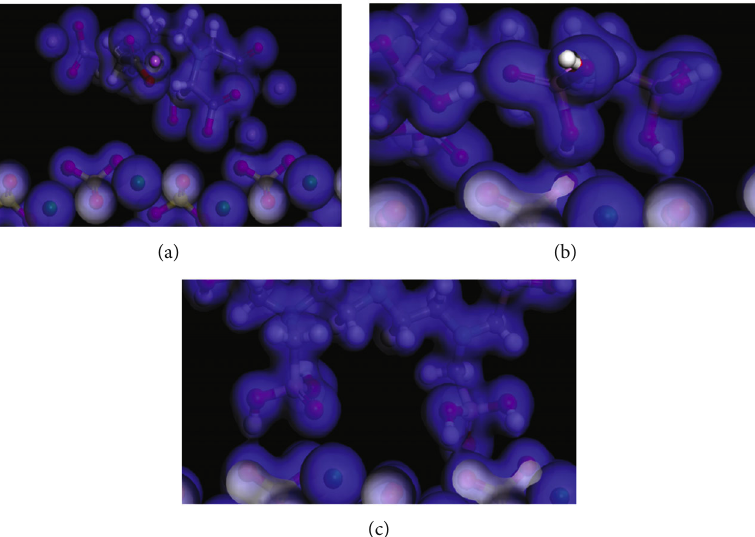
Figure 8: Di ff erence charge density of (a) DTPA-5Na, (b) EDTMPS, and (c) DTPMP are absorbing on (001) surface of barium sulfate.